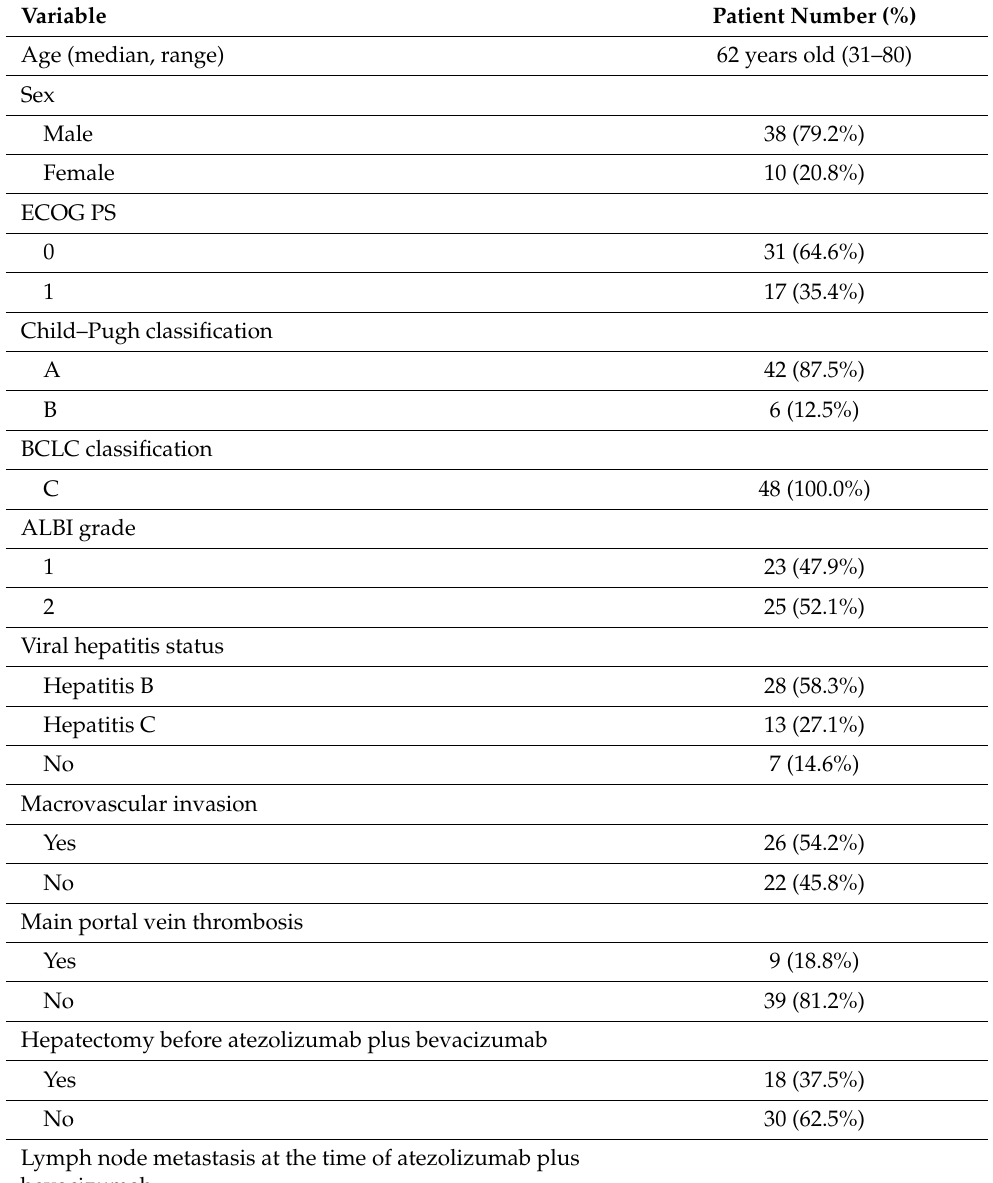
Table 1. Characteristics of 48 patients with unresectable hepatocellular carcinoma who received atezolizumab plus